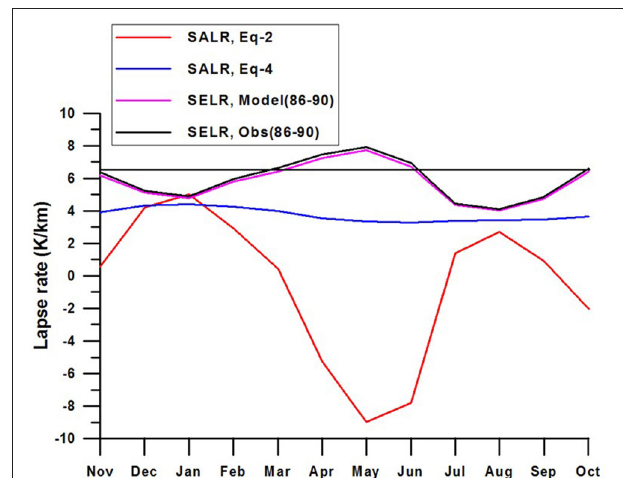
FIGURE 3 | Temperature lapse rate of section 1 of Beas basin between (Kasol, 662m a.s.l. and Manali, 2,050m a.s.l.) calculated by using the Equation (2) and Equation (4) showing significant deviation from the observed SELR highlighting the need for a new approach. Modeled SELR of the section using derived indices shows promising result. Monthly average temperature of 5 years (1986–1990) was used here to develop the monthly indices for the